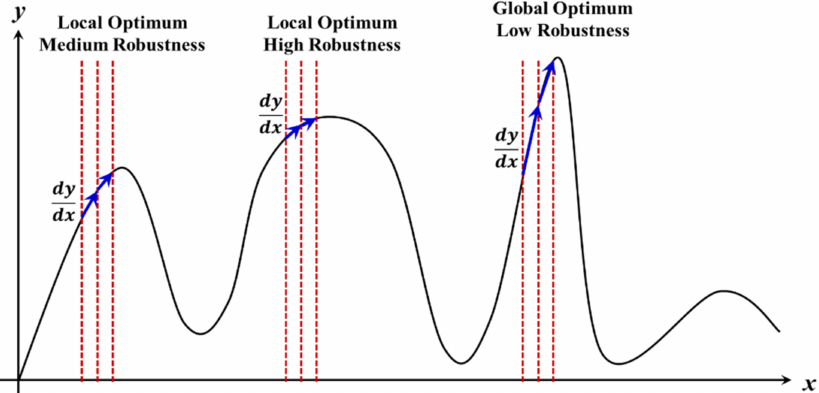
Figure 3. Concept for discrimination of robust solution.